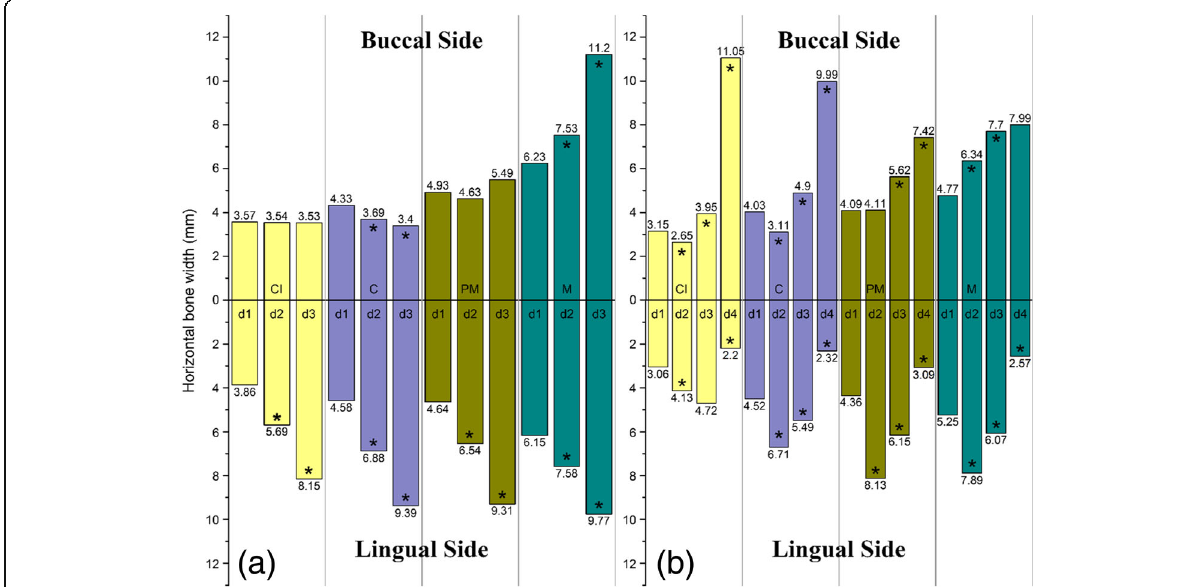
Fig. 3 Comparison of horizontal alveolar widths between a maxillary and b mandibular alveolar bone. CI, central incisors; C, canines; PM, premolars; M, molars; d1=bone width at the crestal level; d2=bone width at the mid-root level; d3=bone width at root the apex level; d4=bone width at the mandibular border level (* P